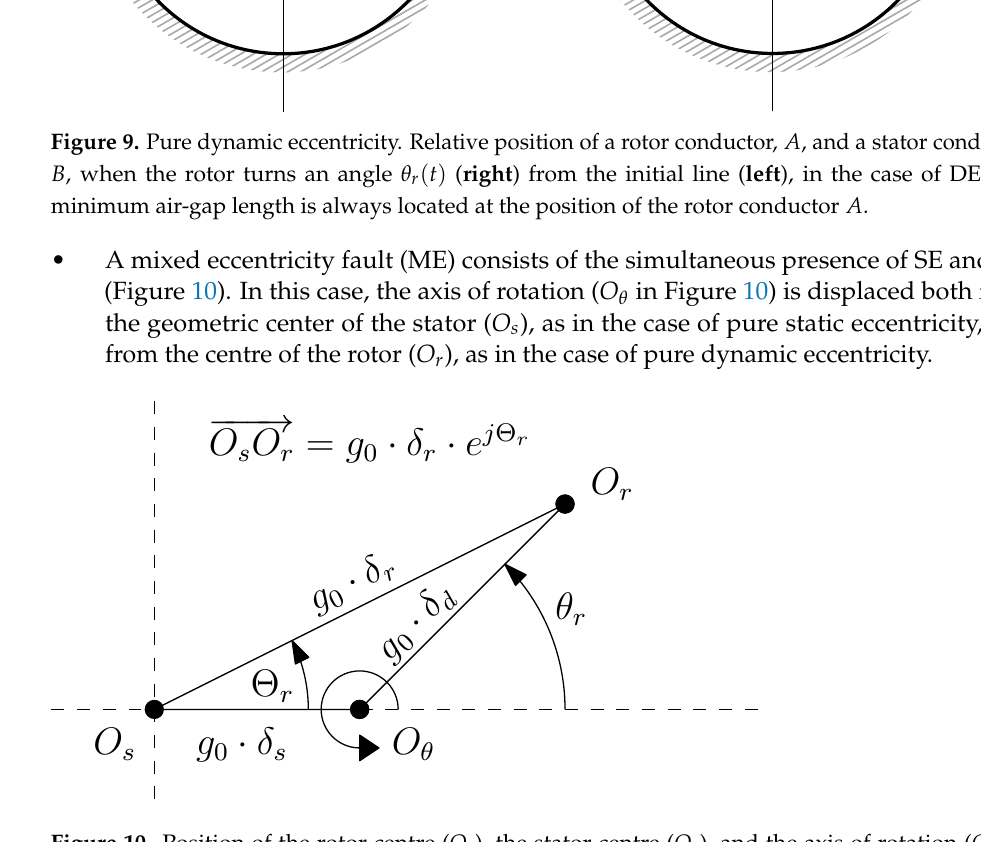
Figure 10. Position of the rotor centre ( O r ), the stator centre ( O s ), and the axis of rotation ( O θ ) in case of an IM witth ME eccentricity ( δ r ), as a geometric combination of static ( δ s ) and dynamic ( δ d ) eccentricity. θ r represents the angle of rotation of the